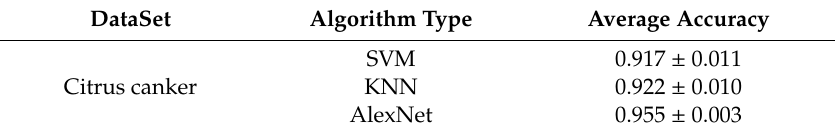
Table A3. Comparison of Support Vector Machines (SVM), K-Nearest Neighbors (KNN), and AlexNet accuracy with 600 real training images. We gathered statistics for 10 training exercises, and the di ff erence was statistically significant ( p < 0.05).